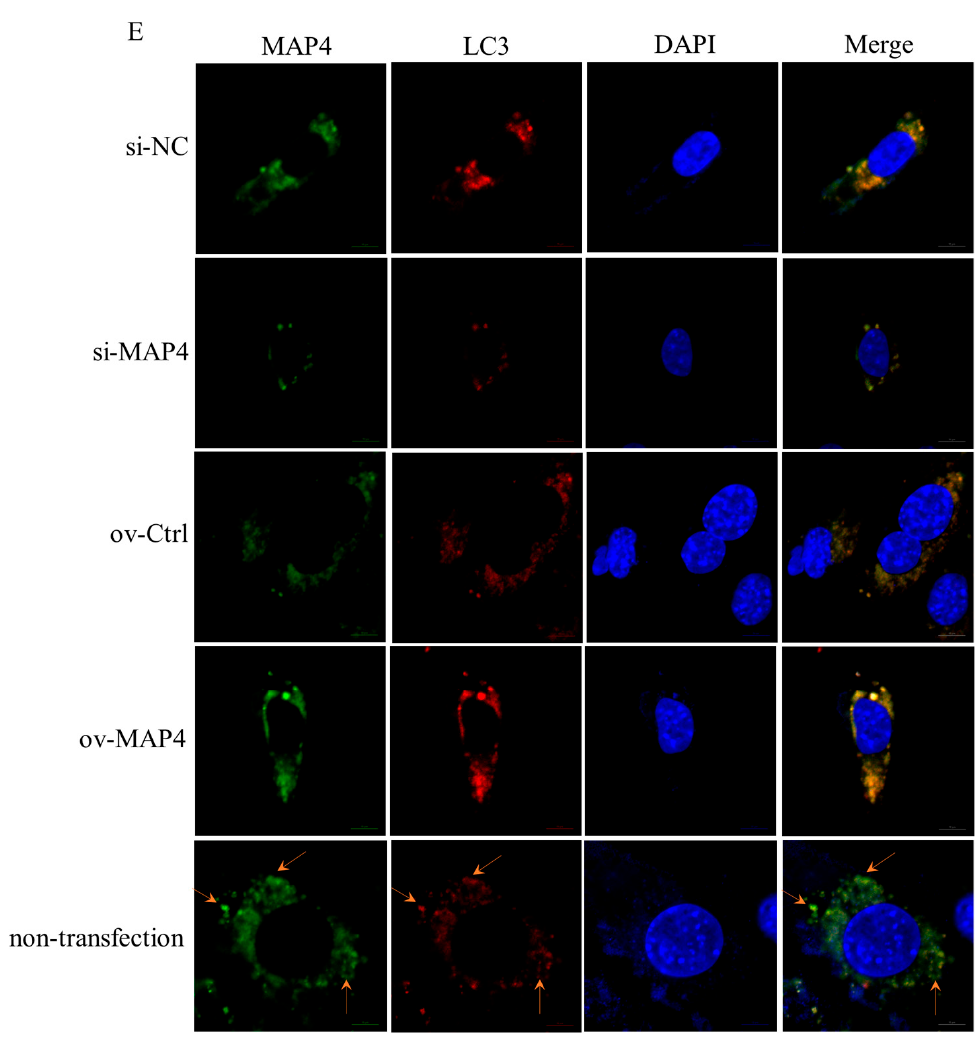
Figure 7. MAP4 interacted with LC3. ( A ) MS/MS spectra of the peptide (IPVIIER) assigned to LC3 from MAP4 immunoprecipitates and the binding peptide within the LC3 amino acid sequence. The yellow highlights is amino acid sequence of LC3. ( B ) MS/MS spectra of the peptide (ETETTLPIK) assigned to MAP4 from LC3 immunoprecipitates and the location within the MAP4 amino acid sequence. The yellow highlights is amino acid sequence of MAP4. Amino acid sequences of LC3 and MAP4 were obtained from Uniprot (https://www.uniprot.org/; accessed on 1 May 2022). ( C ) The immunoprecipitates of MAP4 were purified using anti-MAP4, and the presence of LC3 and MAP4 was analyzed by western blotting. ( D ) The immunoprecipitates of LC3 were purified using anti-LC3, and the presence of MAP4 and LC3 was analyzed by western blotting. ( E ) Immunofluorescence of LC3 (red) and MAP4 (green) was imaged using a confocal microscope, the cell nuclei were visualized by DAPI staining (blue). Yellow arrows indicate the co-localization of MAP4 and LC3. Scale bar = 10 μ m.